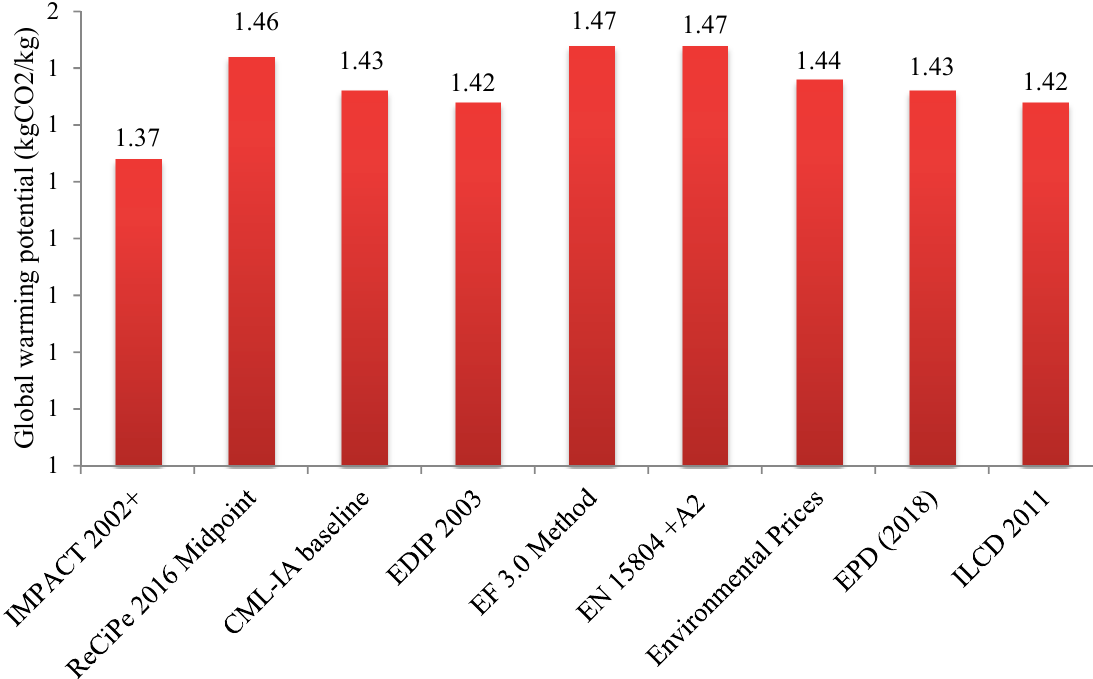
Figure 8. Effect of impact assessment methodology selection on the global warming potential (GWP) results.